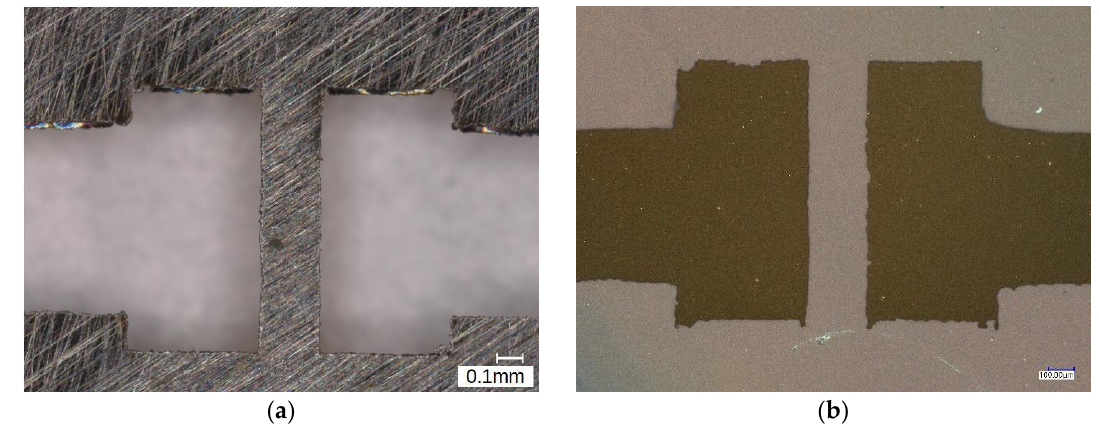
Figure 7. Microscope image of ( a ) shadow mask; ( b ) electrode obtained by vacuum evaporation of gold through shadow mask. The distance between electrodes is 250 µm, magnification ×150.